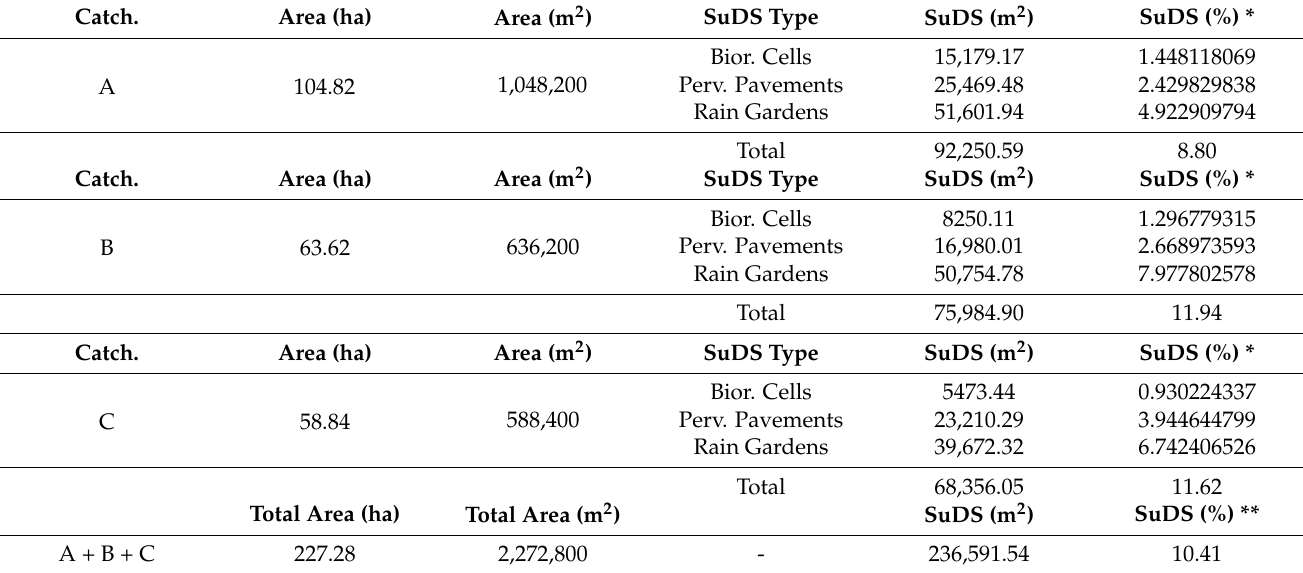
Table 2. SuDS percentages and